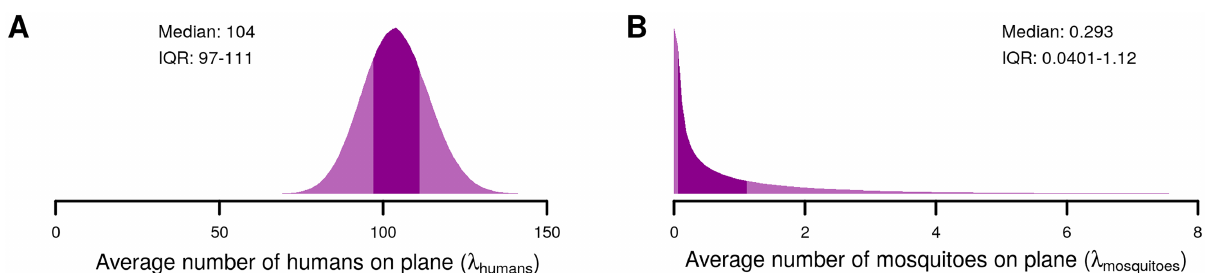
Fig 1. Distributions of the parameters for the averagenumber of humans (A) and mosquitoes (B) on aircraft. The dark shaded areas in each distribution indicate the interquartile range. The median and interquartile range (IQR) of each distribution is shown in the